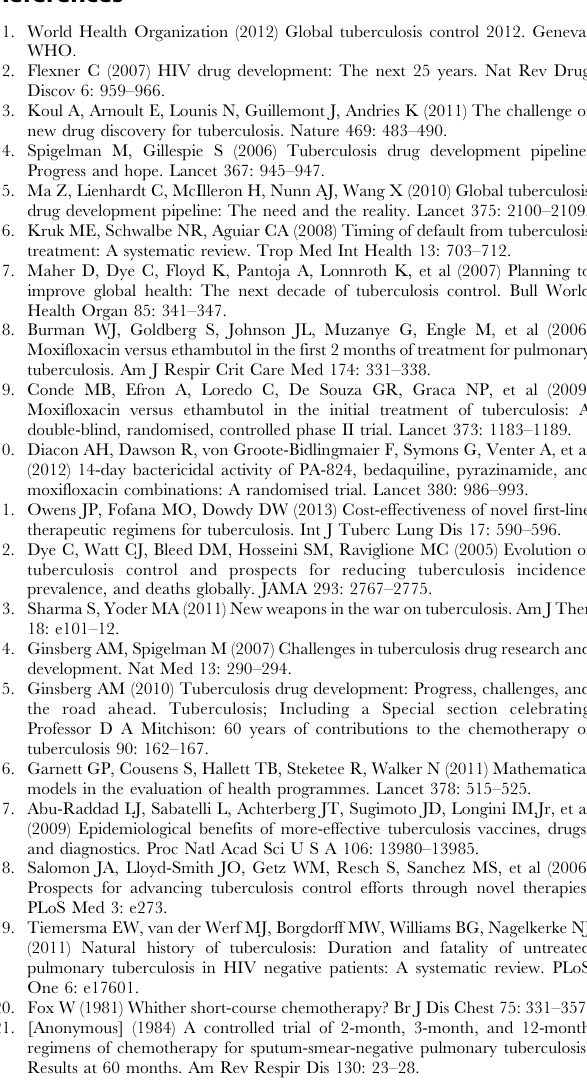
Figure S1 to S3. Table S1: Initial state conditions Table S2: Model parameters Figure S1: Model structure, including param- eter definitions Table S3: Additional sensitivity analysis results Figure S2: Structural sensitivity analyses on (A) latent infection and (B) age structure. Figure S3: Distribution of input values and incidence in uncertainty